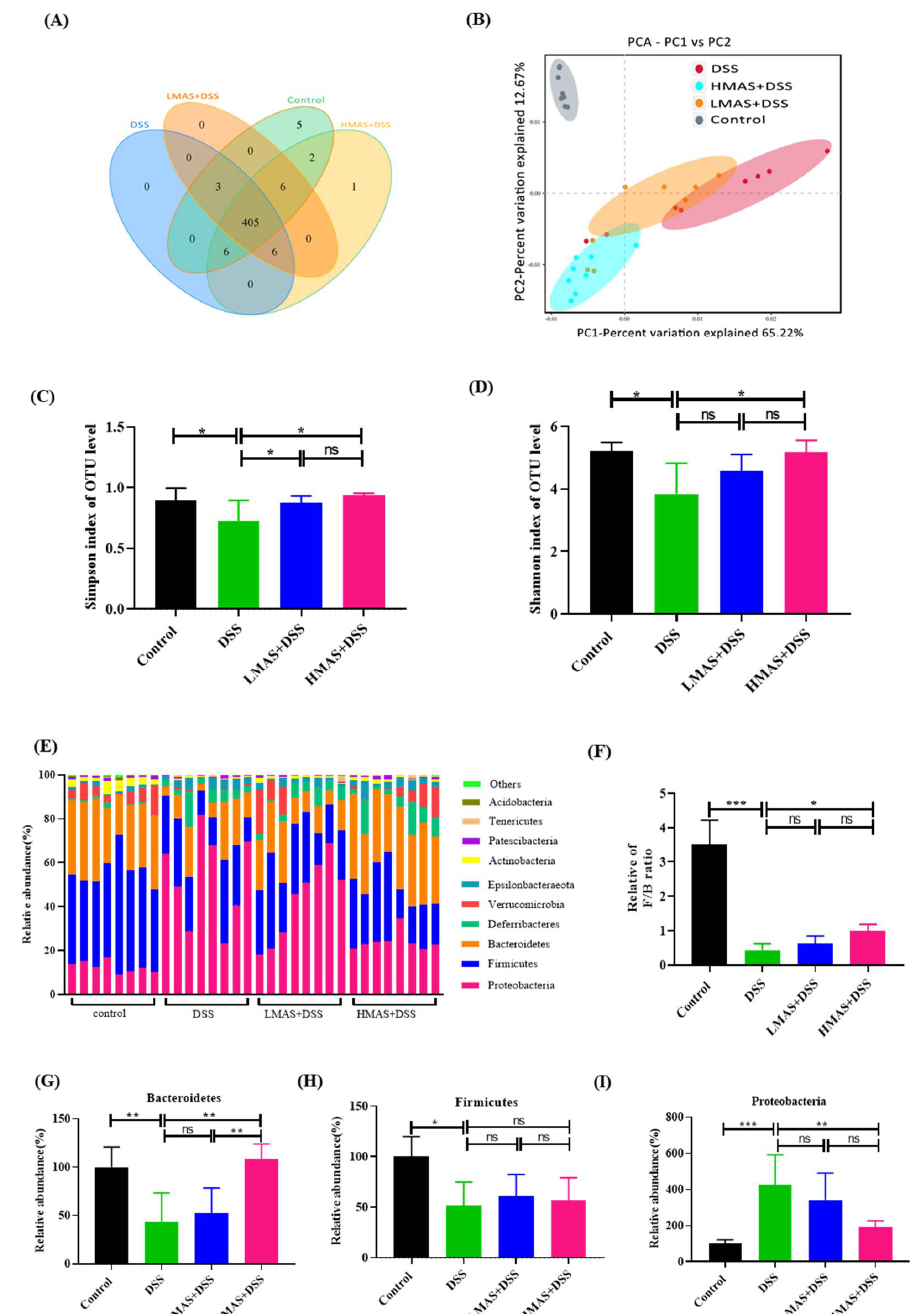
Figure 5. MAS improved the gut microbiota disorder caused by DSS-induced colitis in mice. ( A ) Venn diagram showing the overlap of the operational taxonomic units (OTUs) identified in the gut microbiota among the four groups. ( B ) beta diversity analysis of intestinal microbiota among the four groups using the PCA method. ( C ) Simpson index of all samples. ( D ) Shannon index of all samples. ( E ) Bar chart of the bacterial community composition at the phylum level. ( H ) The Firmicutes to Bacteroidetes ratio. ( F , G ) Relative abundance of Bacteroidetes , Firmicutes at the phylum level, ( I ) Proteobacteria at the phylum level. Here, ns = not significant Data are shown as the mean ± SD. * p < 0.05, ** p < 0.01, *** p < 0.001, in comparison with the DSS group (n = 8).